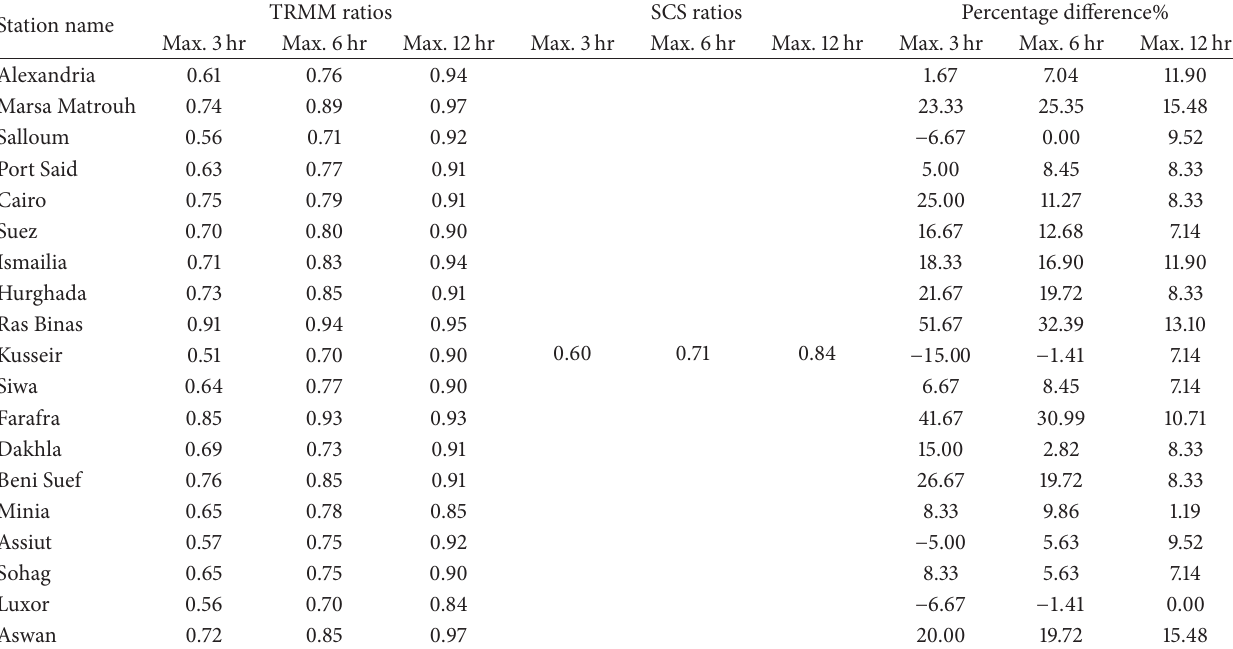
/𝑃 24 hr ratios between SCS type II and hr